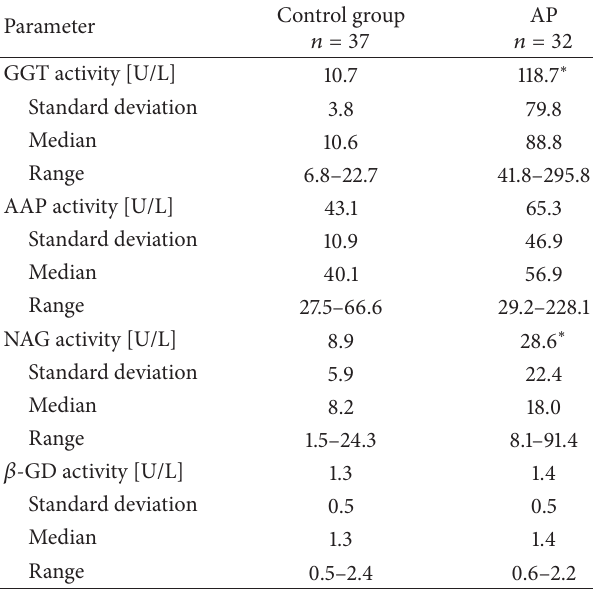
Table 3: The activity of membrane and lysosomal enzymes as a marker of tissue damage in patients with acute pancreatitis compared to control group.